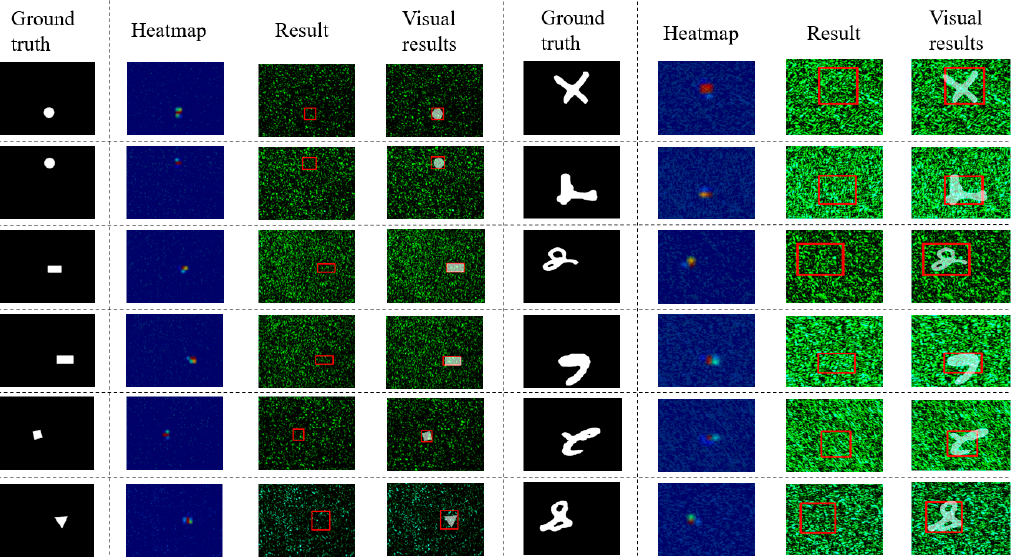
Figure 9. Test results for the validation set and a single target dataset of different categories. The “Heatmap” column presents the heatmaps of the output network, where warm colors indicate large values and cool colors indicate small values, i.e., red represents the highest confidence in the regression out of the target position box. The “Result” column presents the output of the network. The “Visual results” column presents results that were used to better characterize the location prediction results. The red box represents the target location results output by the model.